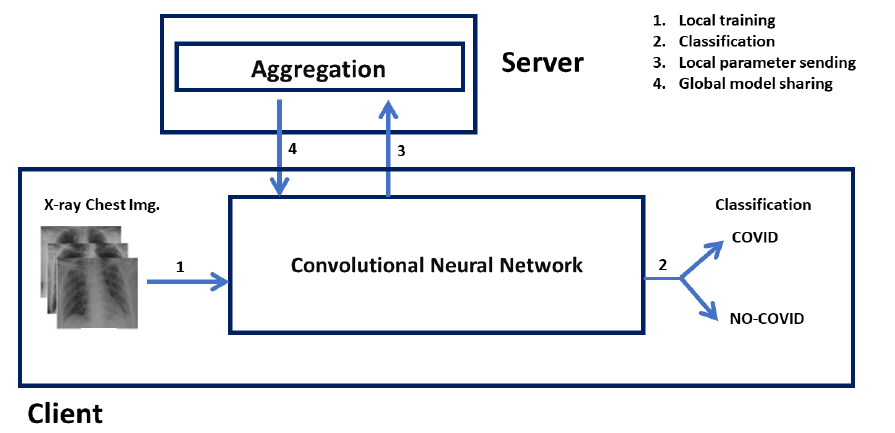
Figure 1. Local training and global aggregation workflow.